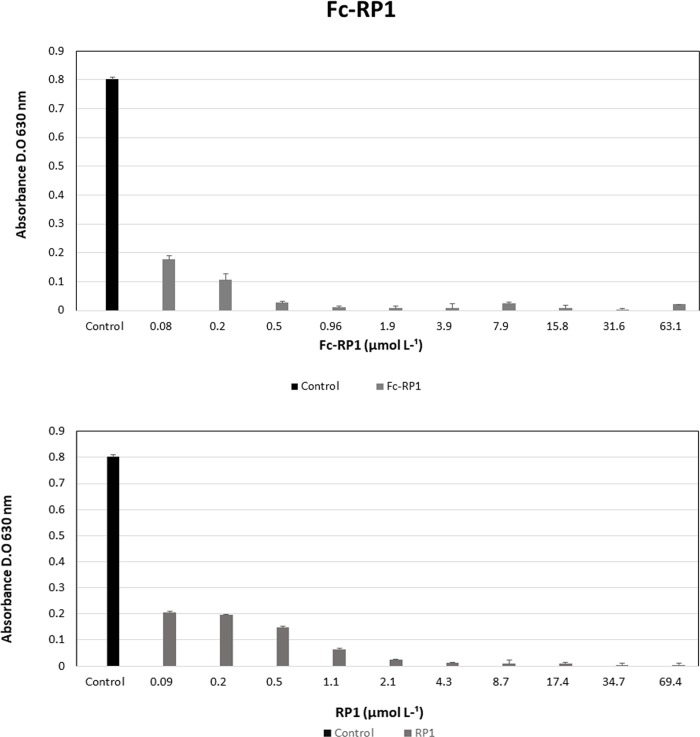
Antibacterial assays of the peptides RP1 and Fc-RP1 in S. agalactiae (Gram-positive).Peptides were diluted in ultrapure water and positive control (bacterium and Mueller Hinton broth). Data are expressed as averages plus standard deviations (SD) from three independent experiments (P <0.05) a statistically significant difference of the different experimental points. According to Tukey's test, the tested peptide concentrations differ statistically from each other, being represented by different letters on the tested drug concentrations.